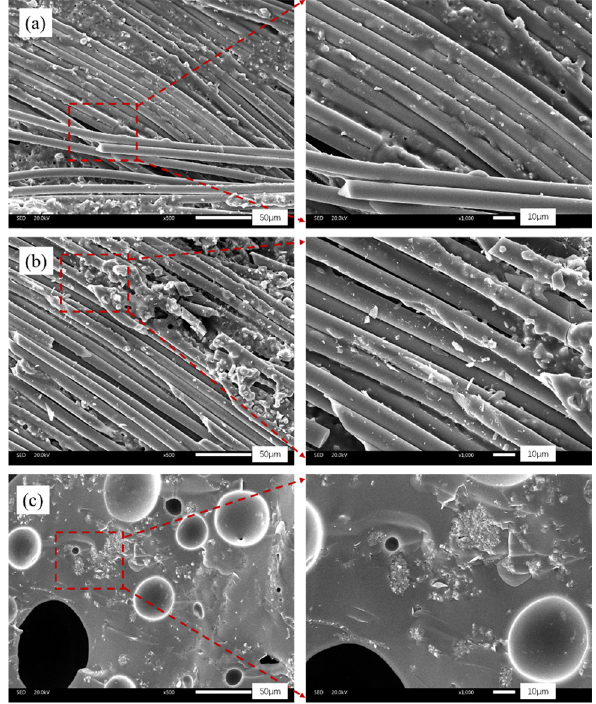
Figure 6: Scanning electron microscope images of composites: ( a ) A - 2, ( b ) A - 4, and ( c ) A -